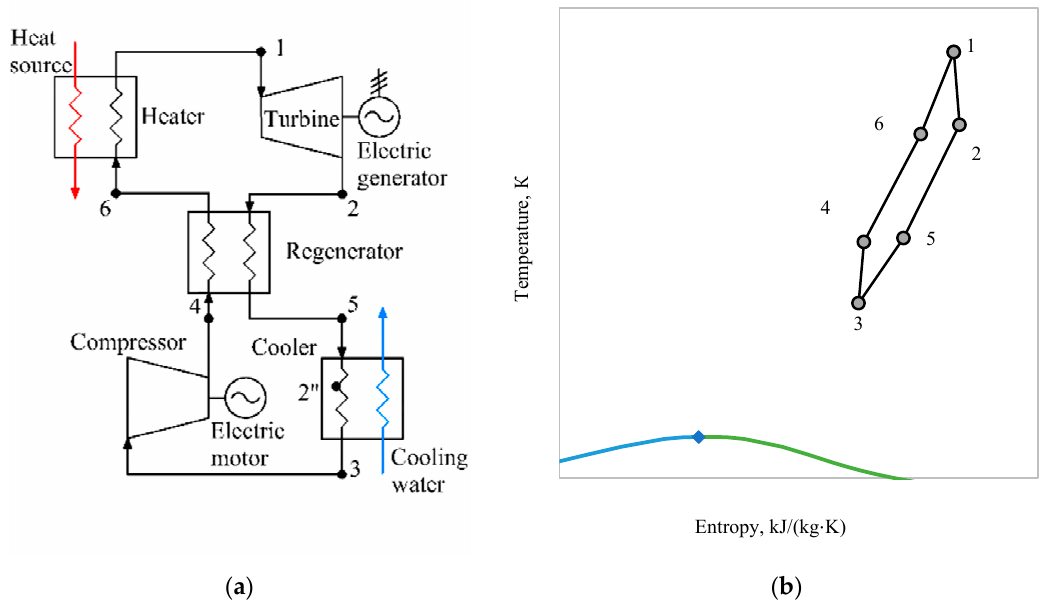
Figure 6. Brayton cycle with regeneration: ( a ) Scheme; ( b ) Cycle.